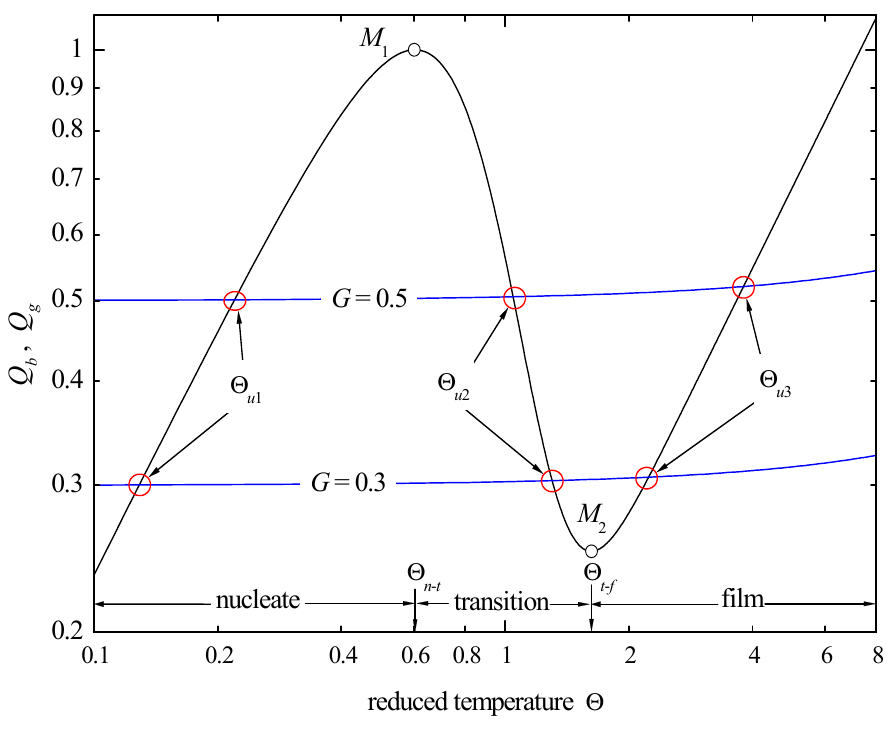
Figure 2. Uniform solutions ∆ Q = Q c ( Θ ) − G ρ ( Θ ) = 0 .